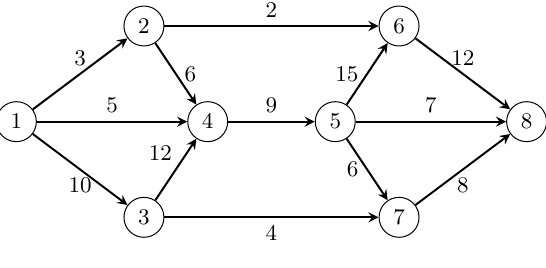
Figure 2: A small CPM network.